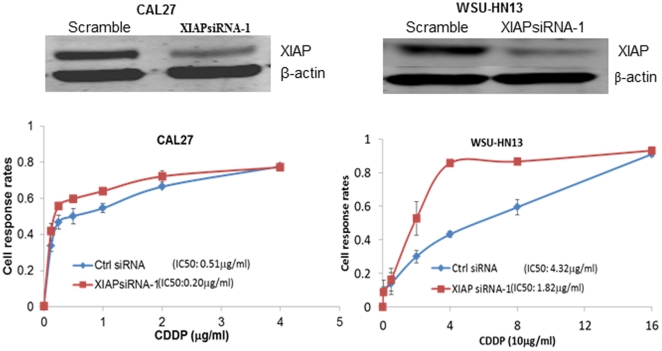
Inhibiting XIAP expression sensitized both CAL27and WSU-HN13 to cisplatin treatment.XIAP siRNA-1 effectively inhibited the expression of XIAP protein in both CAL27 and WSU-HN13 cells (Upper) and decreased the cisplatin IC50 value from 0.51 µg/ml to 0.20 µg/ml in CAL27 and from 4.32 to 1.82 µg/ml in WSU-HN13 (Lower).